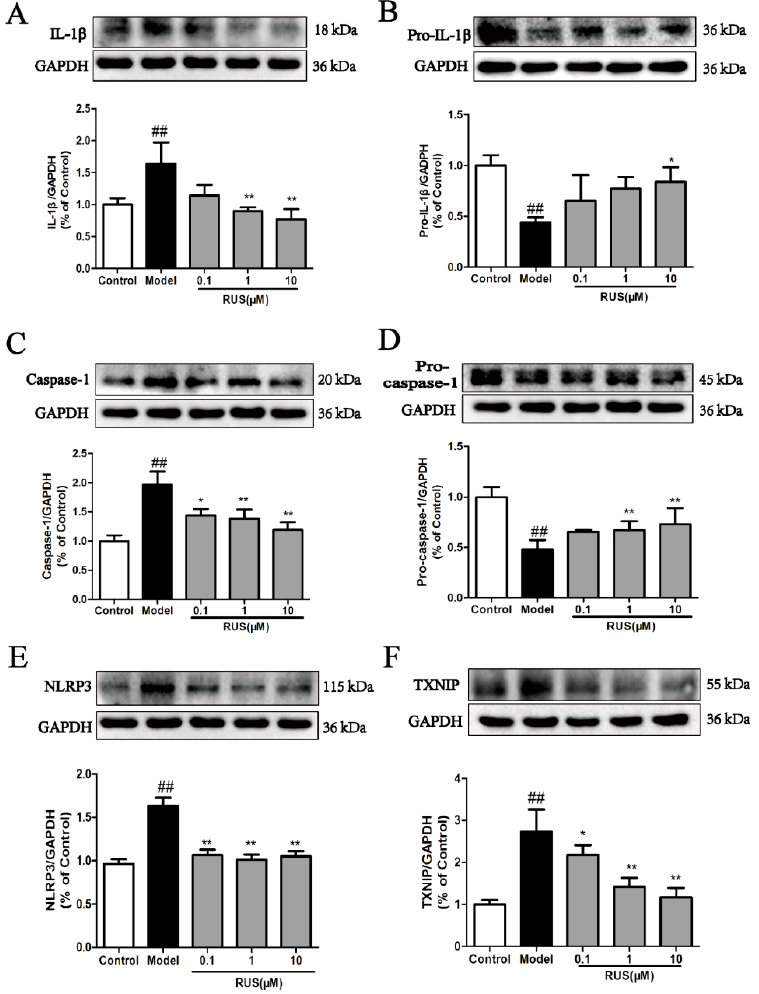
Figure 7. Effects of ruscogenin on the TXNIP/NLRP3 pathway in bEnd.3 cells subjected to OGD/R. ( A – F ) Representative Western blot bands and quantitative analysis of the ratio of IL-1 β and pro-IL-1 β , caspase-1 and pro-caspase-1, NLRP3 and TXNIP. The band intensities were measured using scanning densitometry. The data were normalized to GAPDH expression ( n = 3). The data are expressed as means ± SD. ## p < 0.01 ν s. Control, * p < 0.05, ** p < 0.01 ν s. Model.